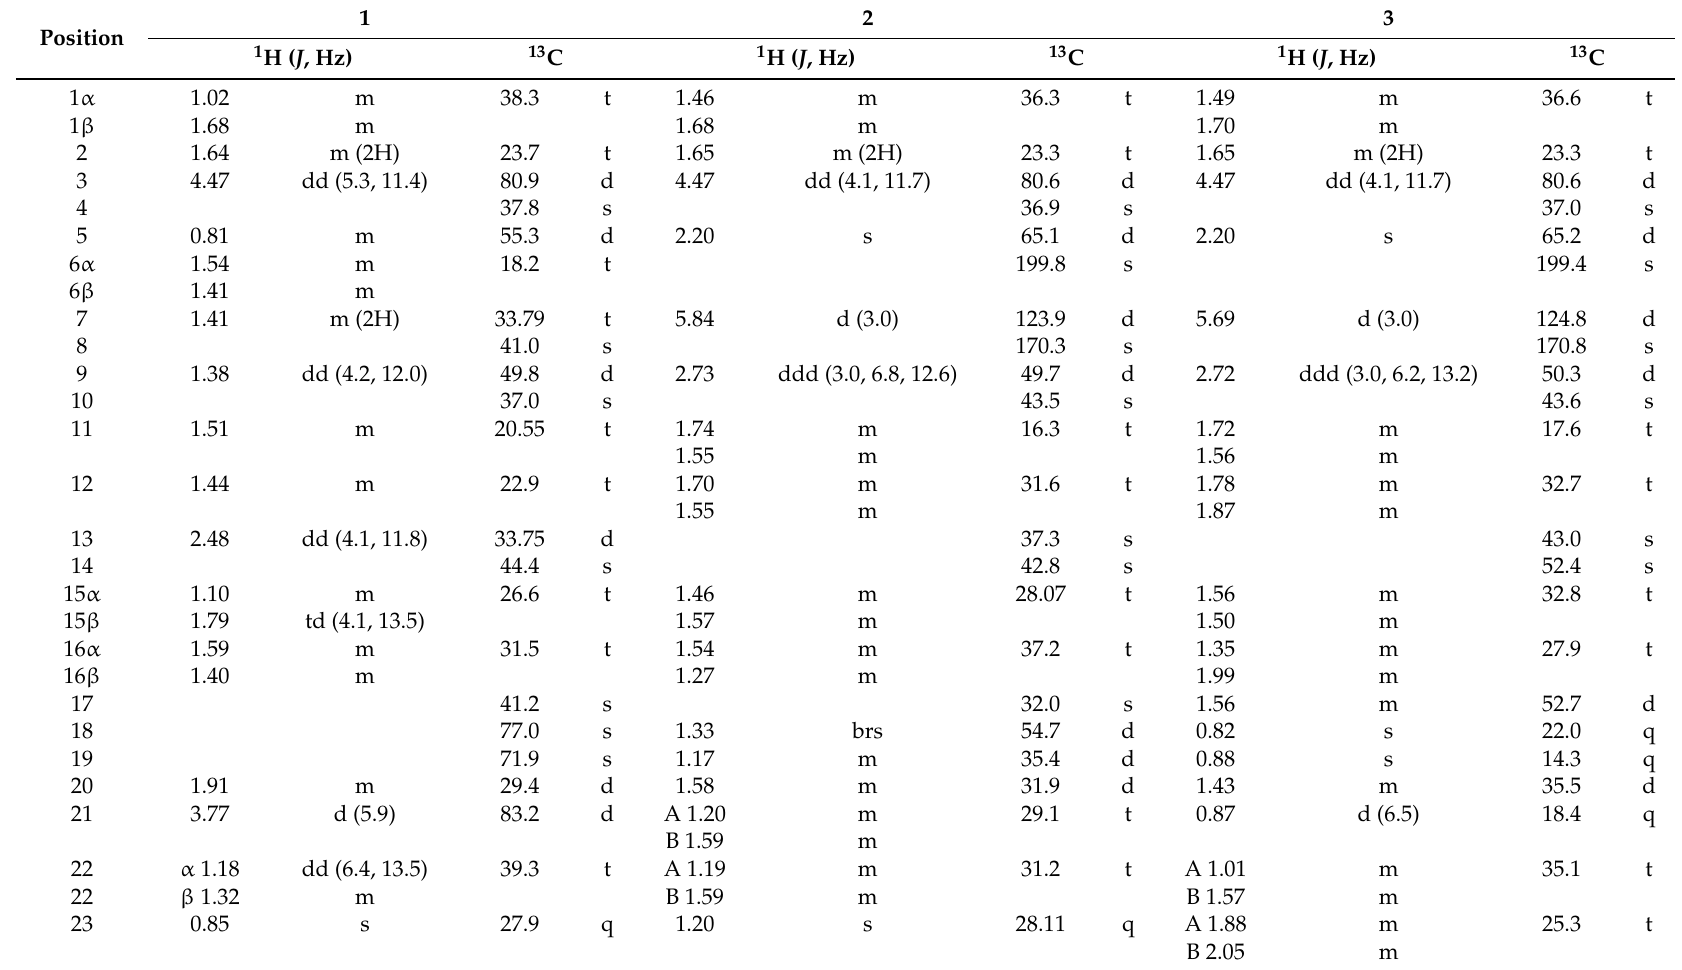
Table 1. 1 H- (600 MHz) and 13 C- (150 MHz) NMR data of compounds 1 – 3